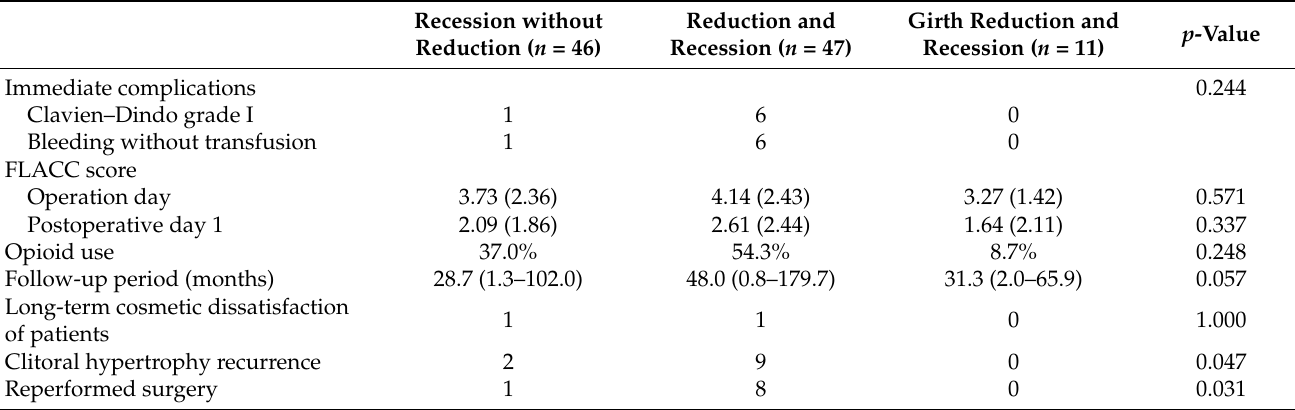
Table 3. Postoperative complications and surgical